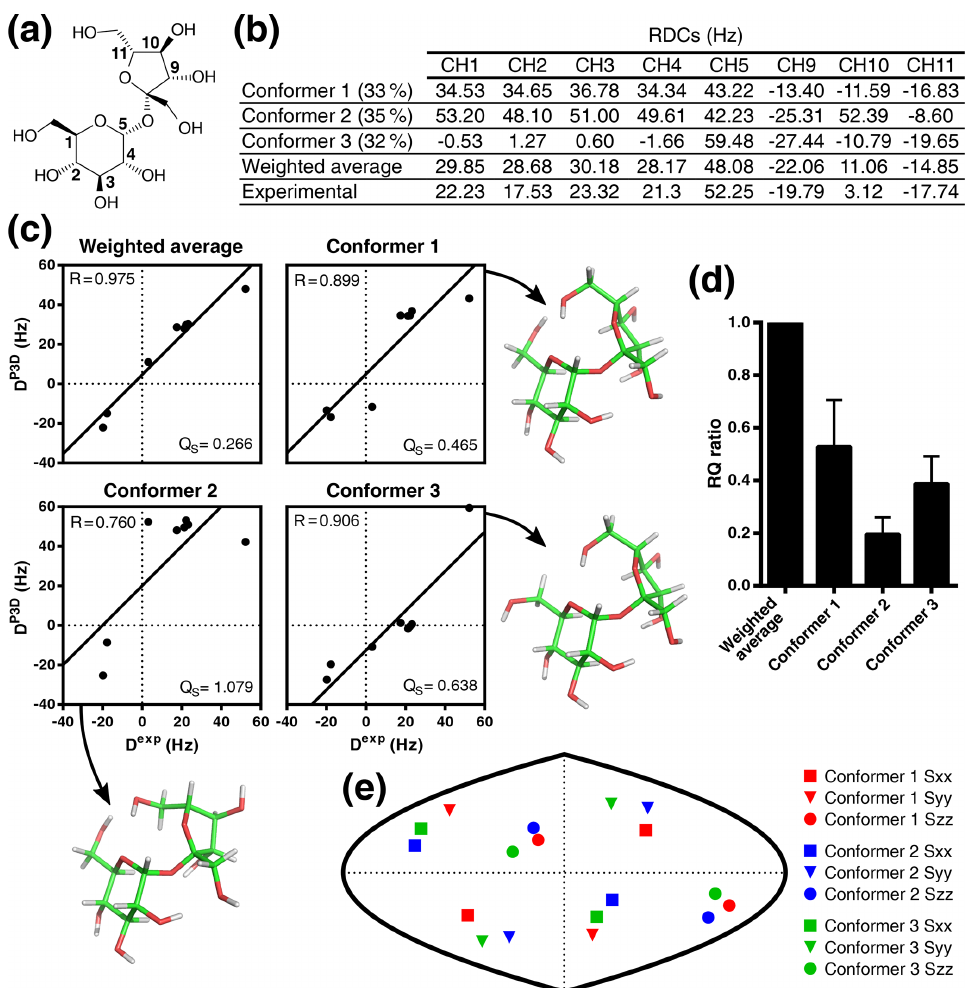
Figure 5. Validation of the conformational ensemble of sucrose using P3D. (a) Sucrose structure with the CH carbons labeled. (b) List of P3D-simulated RDCs for the three conformers together with the average weighted RDCs (from Ndukwe et al., 2019 populations) and the experimental RDCs. (c) Correlations between the experimental RDCs (D exp ) and the P3D-simulated RDCs for the three conformers and the weighted average. (d) RQ ratios of the three different conformers in reference to the weighted average. Error bars are calculated as the propagation of R and Q S errors, and these errors are calculated from the SD of 100 repetitions, including noise in the RDCs. (e) Comparison of the orientation of the P3D-predicted alignment tensors for the three conformers. The orientation of the three axes corresponding to the eigenvalues Szz (circle), Syy (triangle), and Sxx (square) of the diagonalized alignment tensor are projected onto a two-dimensional world